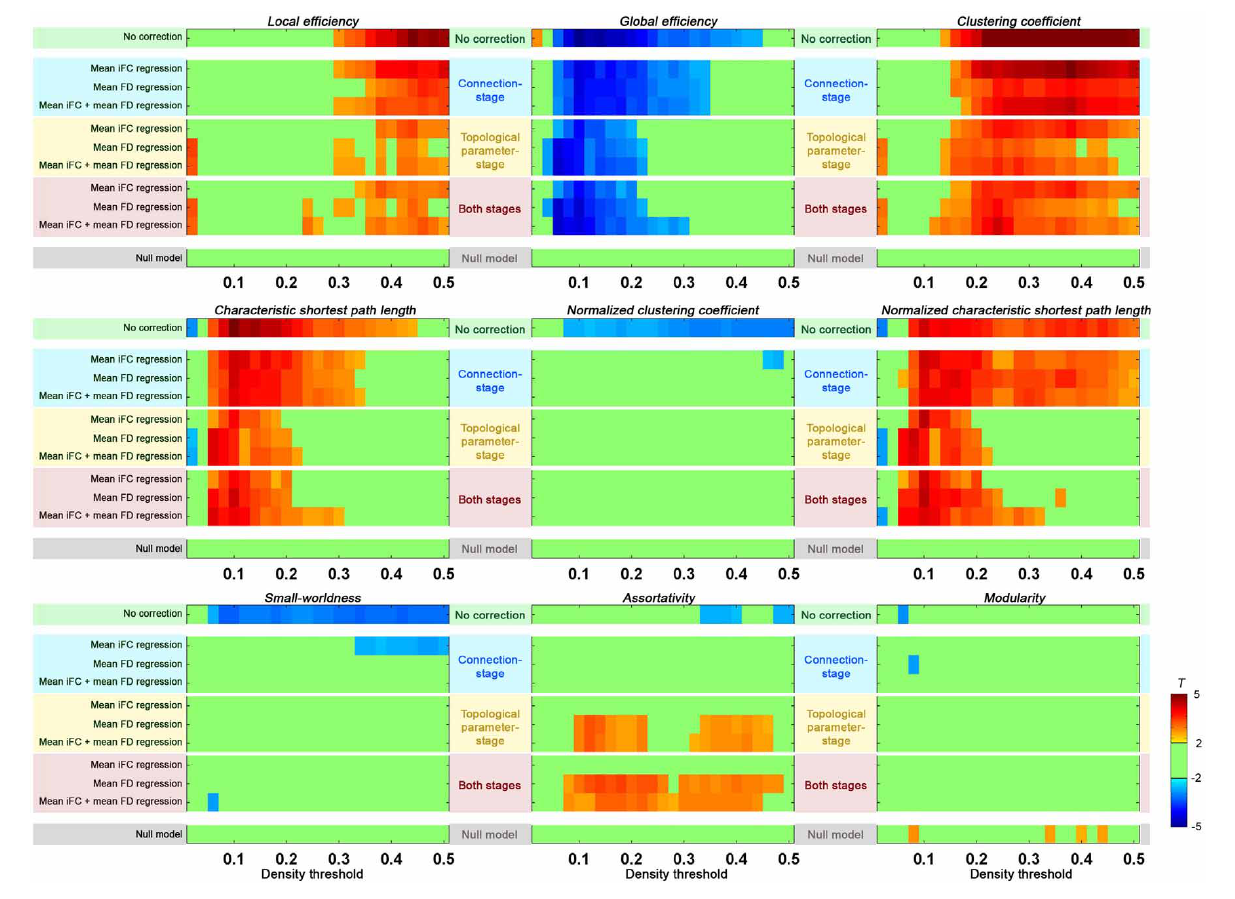
and age). The group-level correction was performed either at connection-stage (i.e., applied to the connections before topological parameter calculation), at topological parameter-stage (i.e., applied to the topological parameters after their calculation), or at both stages. For each stage, the mean iFC, mean FD, or both mean iFC + mean FD were regressed